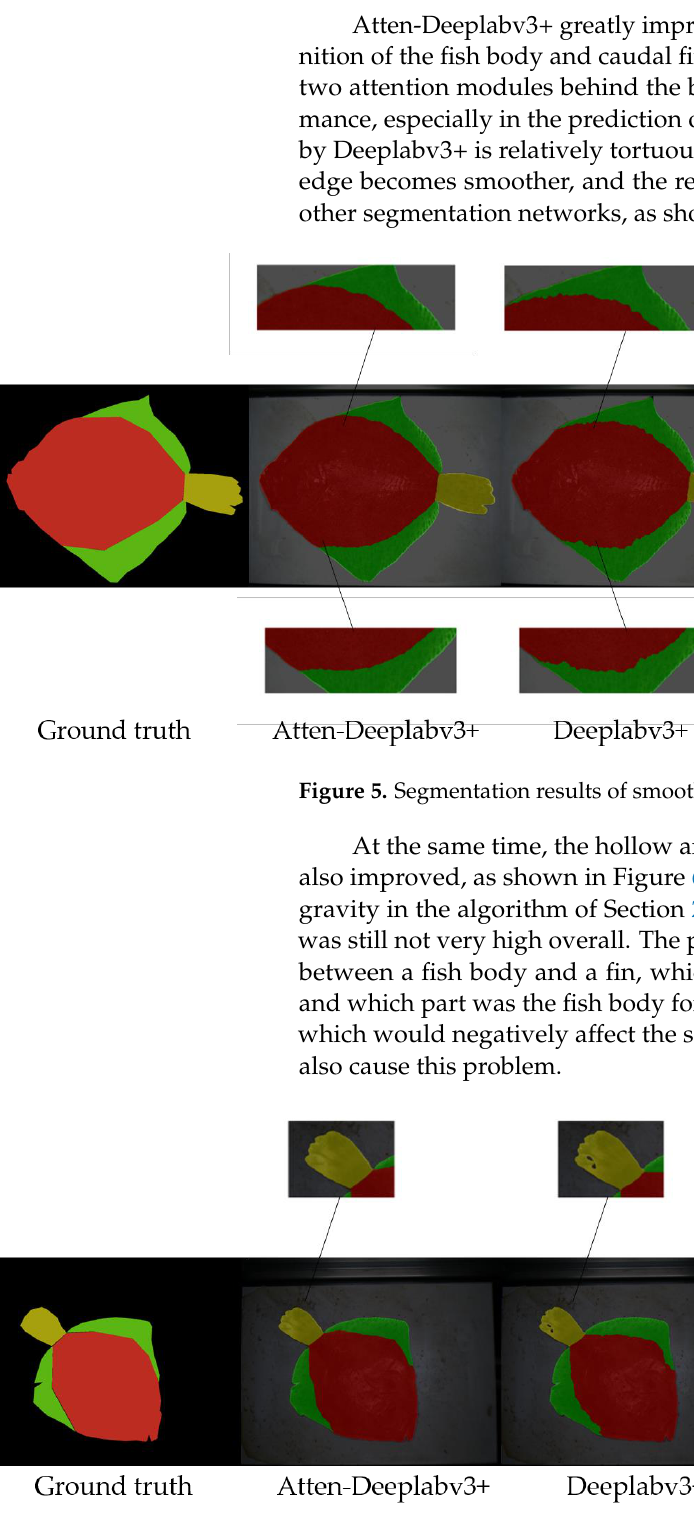
Figure 6. Segmentation results for hollow improvement.